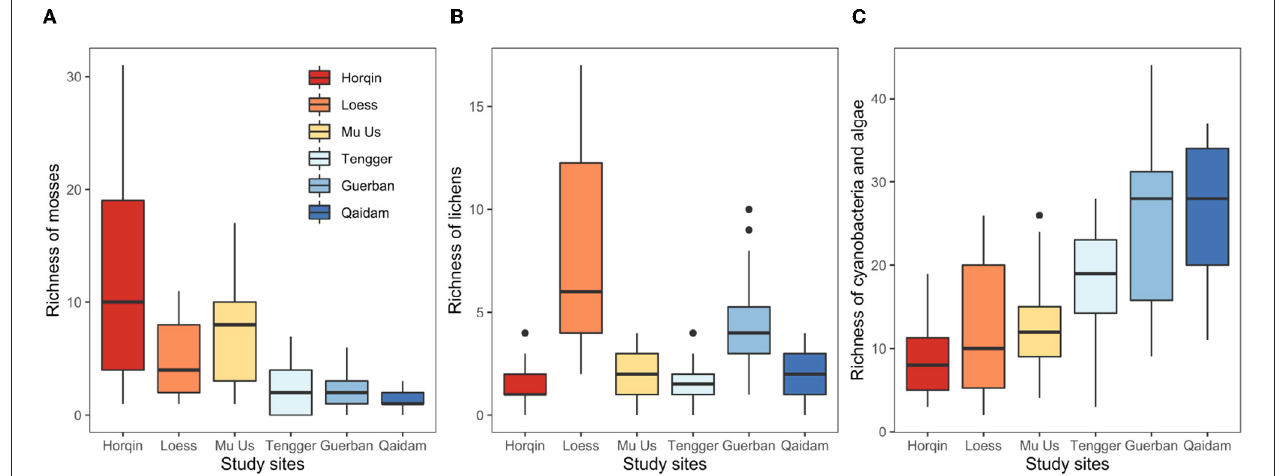
FIGURE 3 | Biotic indicators include the richness of mosses (A) , lichens (B) , and cyanobacteria-algae (C) the biomass of biocrusts and the cover of perennial plants of the study sites (mean (SD)) in northern Chinese deserts.